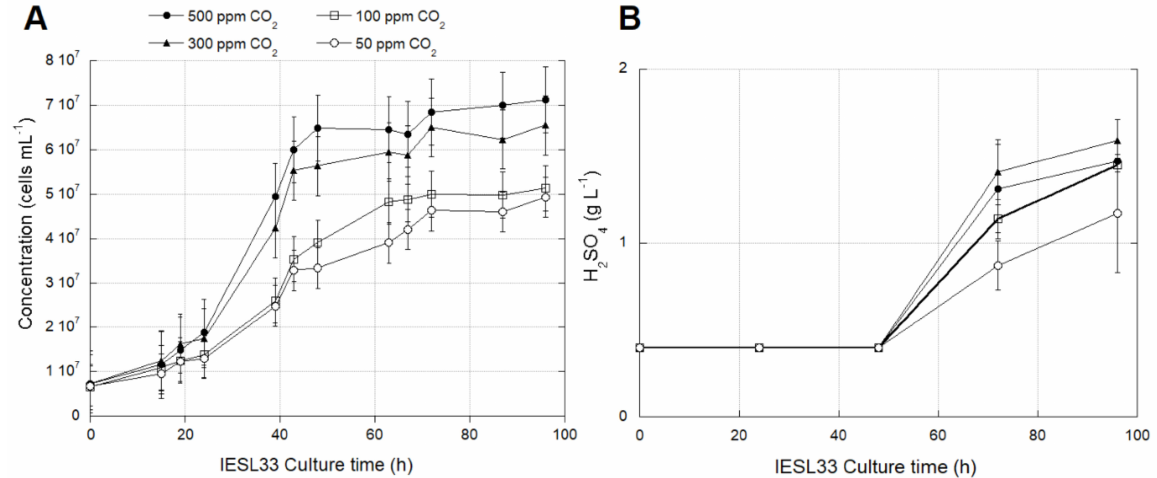
Figure 2. Cell growth ( A ) and acid production ( B ) of At. thiooxidans IESL-33 cultured under different CO 2 concentrations. Vertical bars represent the standard deviation (SD) calculated with biological